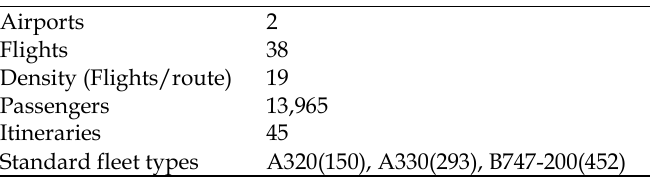
Table 4. Data instance for the airport-pair network